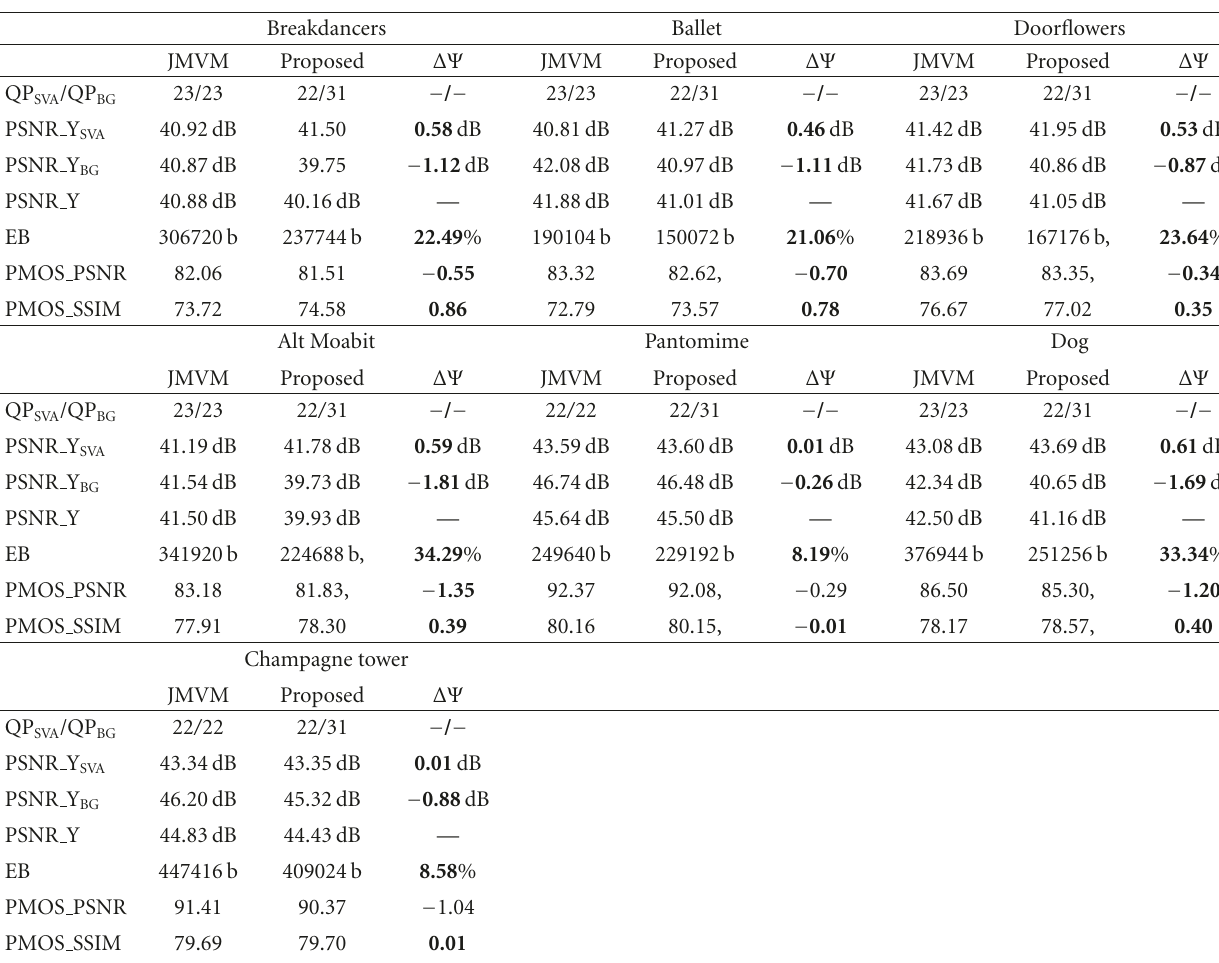
Table 3: Objective image quality and coding bits corresponding to Figure